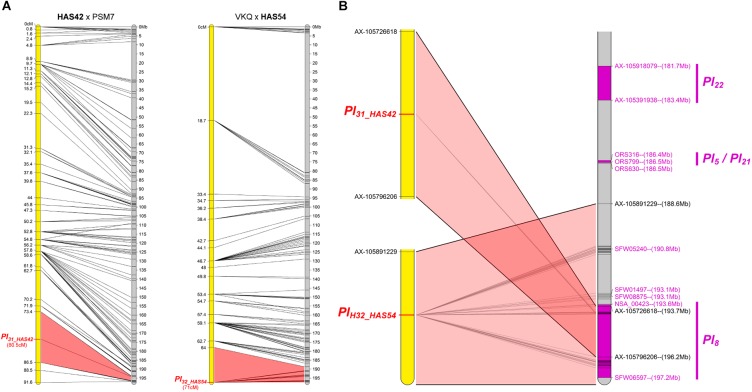
Two new downy mildew resistances map to chromosome 13 of sunflower, close to Pl8.
(A) Genetic (yellow) and physical (gray) maps of the Pl31_HAS42 and Pl32_HAS54 resistance genes on chromosome 13. The cross used to map the resistance is indicated on top of each map, with the resistant parent in bold. Only the non-redundant SNP markers are indicated with their genetic (left map) and corresponding physical positions on the XRQ genome (right map). (B) Enlarged view of the physical map showing the localization of Pl31_HAS42 and Pl32_HAS54 genes. Pl22, Pl5, Pl21, and Pl8 resistance genes were localized according to published linked genetic markers (Vincourt et al., 2012; Qi et al., 2017). The polymorphic SNP markers of the sunflower AXIOM® array denominated AX-xxxxxxxxx are indicated with their physical positions on the sunflower XRQ genomic sequence.